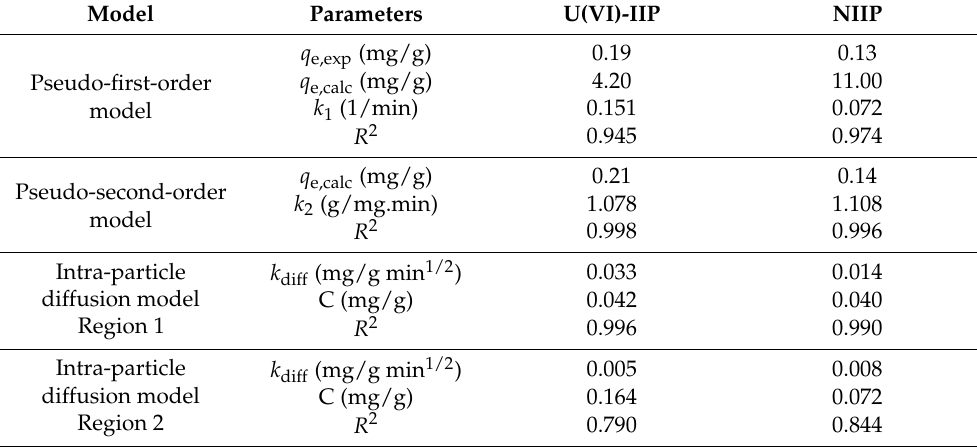
Table 1. Comparison of pseudo-first-order kinetics and pseudo-second-order kinetics constants and experimental and calculated q e values. (pH 7; sorbent dose: 100 mg/10 mL; C 0 = 2 mg U(VI)/L, temperature 298